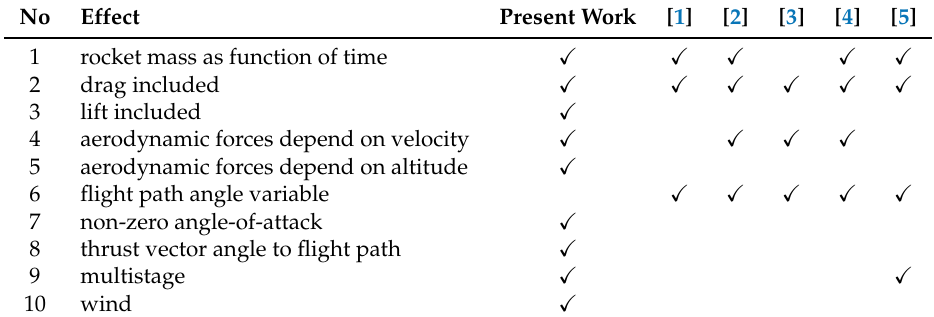
Table 1. Effects included in the calculation of rocket trajectories in the literature [1–5] and in this